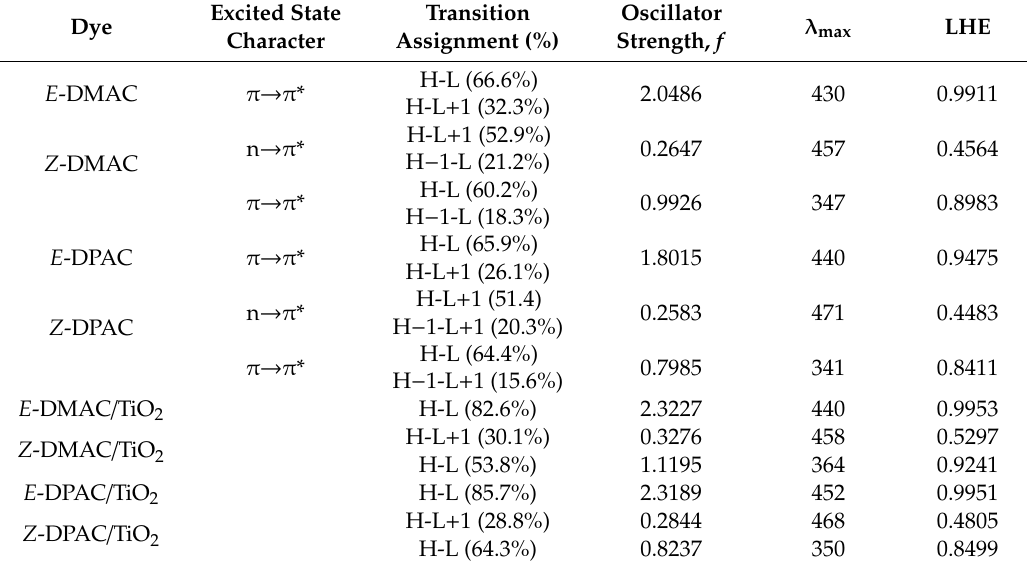
Figure 4. UV-Vis absorption spectra of cis and trans isomers of DMAC and DPAC as ( a ) isolated dyes and ( b ) dye/TiO 2 complexes. Table 2. Maximum absorption wavelengths ( λ max ), oscillator strengths ( f ), excited state transition characteristics, nature of the transitions for the most relevant transitions of the electronic absorption bands, and light-harvesting efficiencies (LHEs) of the dyes.